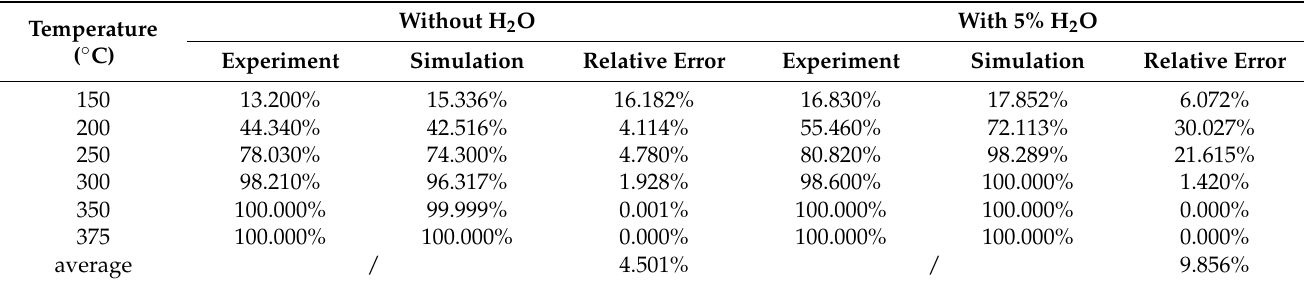
Table 8. The results with relative errors of NH 3 conversion between experiment and simulation under two operating